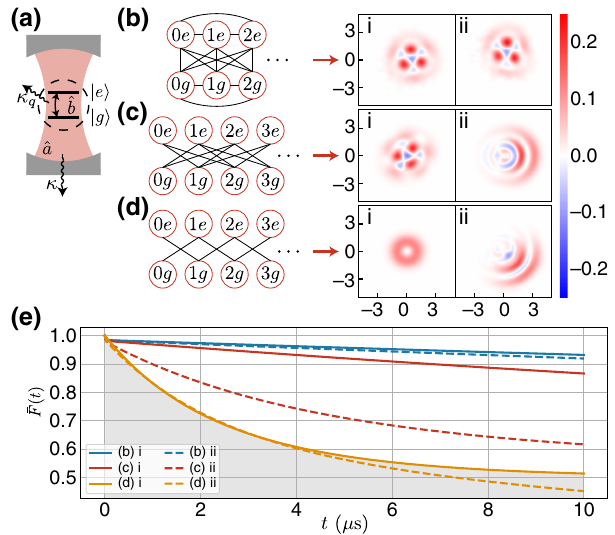
FIG. 2. Optimization results for different Hamiltonian dis- tances. (a) Schematic of a single bosonic mode ˆ a coupled to a ˆ lossy ancilla qubit b . (b)–(d) Wigner functions of the discovered codes for all-to-all (b), distance d = 2 (c), and d = 1 (d) Hamil- tonians. Here i and ii are two of the discovered encodings from many runs of AutoQEC for each Hamiltonian setting. (e) Aver- age fidelity for all-to-all (blue), d = 2 (red), and d = 1 (yellow) results. The gray shaded region indicates fidelities below or equal to the break-even